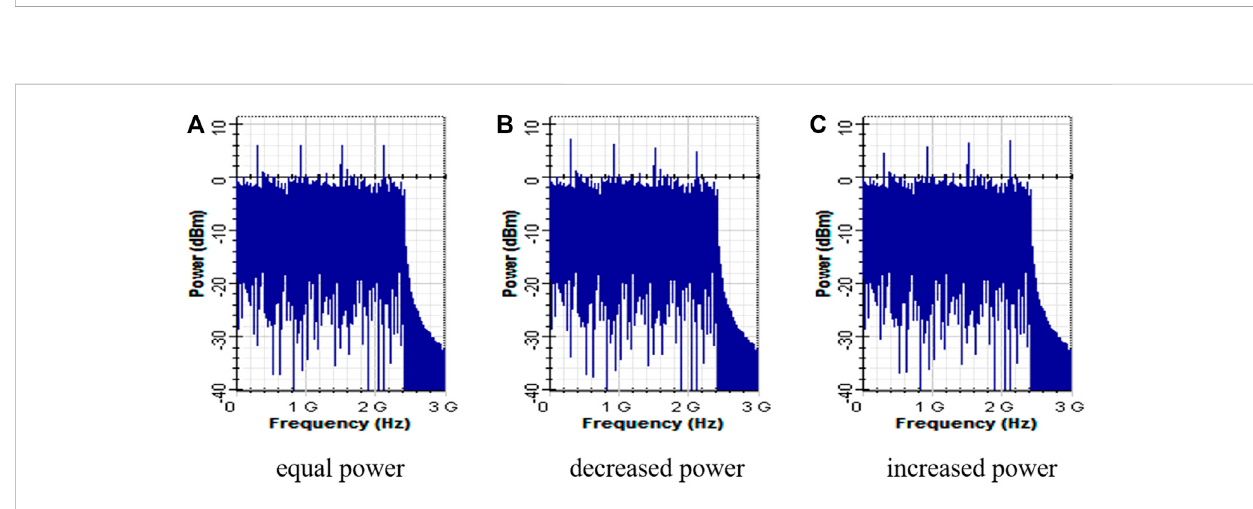
FIGURE 8 OFDM spectrum of different pilot power schemes in the transmitter. (A) The equal-power scheme; (B) The decreased-power scheme; (C) The increased-power